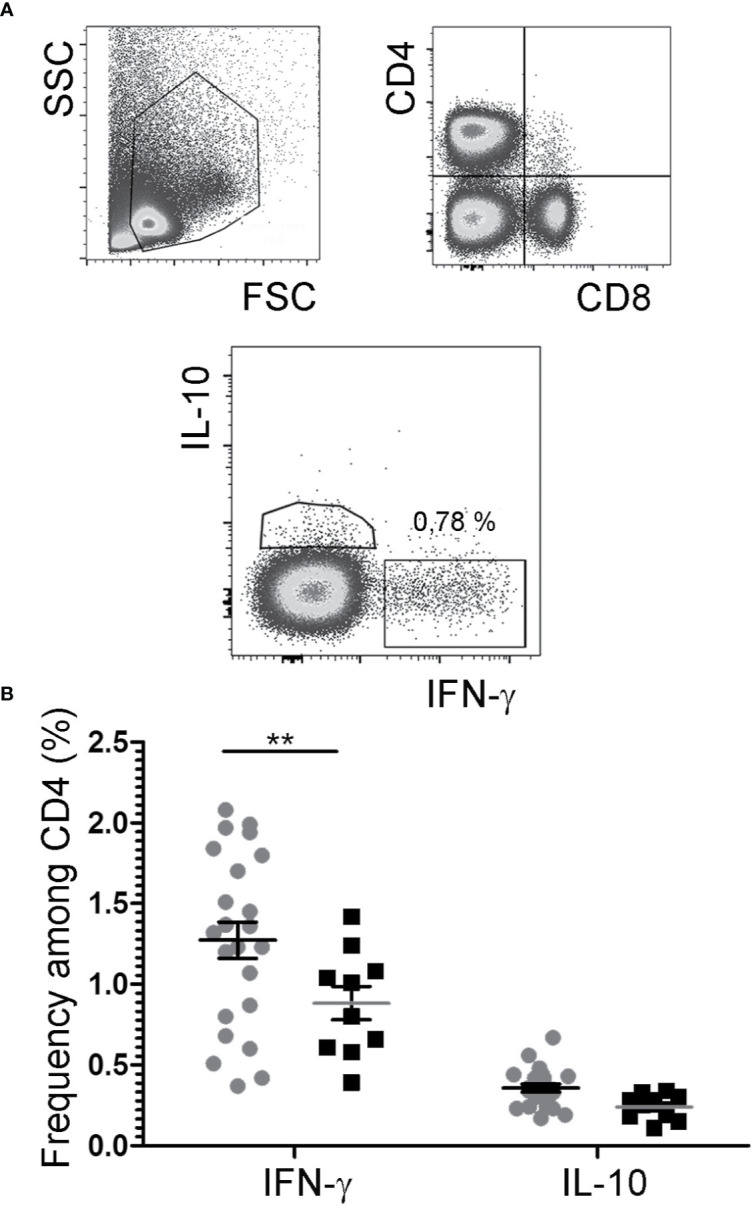
Cytokine expression by CD4+ T cells. After challenge 15, allergic mice were therapeutically inoculated for three days with IL-2/JES6 and analyzed 4 h after the last IL-2/JES6 injection. Cells from mesenteric LNs were stained for lineage markers and intracellular cytokine expression and analyzed by flow cytometry. (A) Gating. (B) Percentage of IFN-γ- and IL-10-expressing CD4+ cells in IL-2/JES6 (circles) and PBS treated controls (squares). Data represent mean ± SEM (n = 10 to 23). **p < 0.01 (two-way ANOVA with Bonferroni past post hoc test).